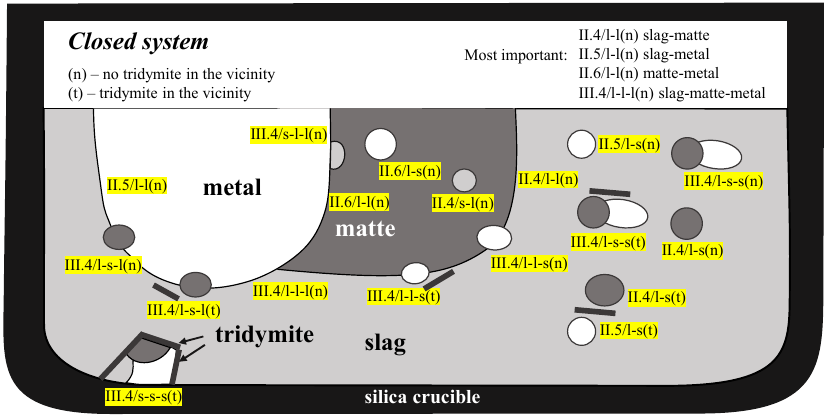
Figure 6. Schematic diagram for classification of macro- and micro-locations in the closed